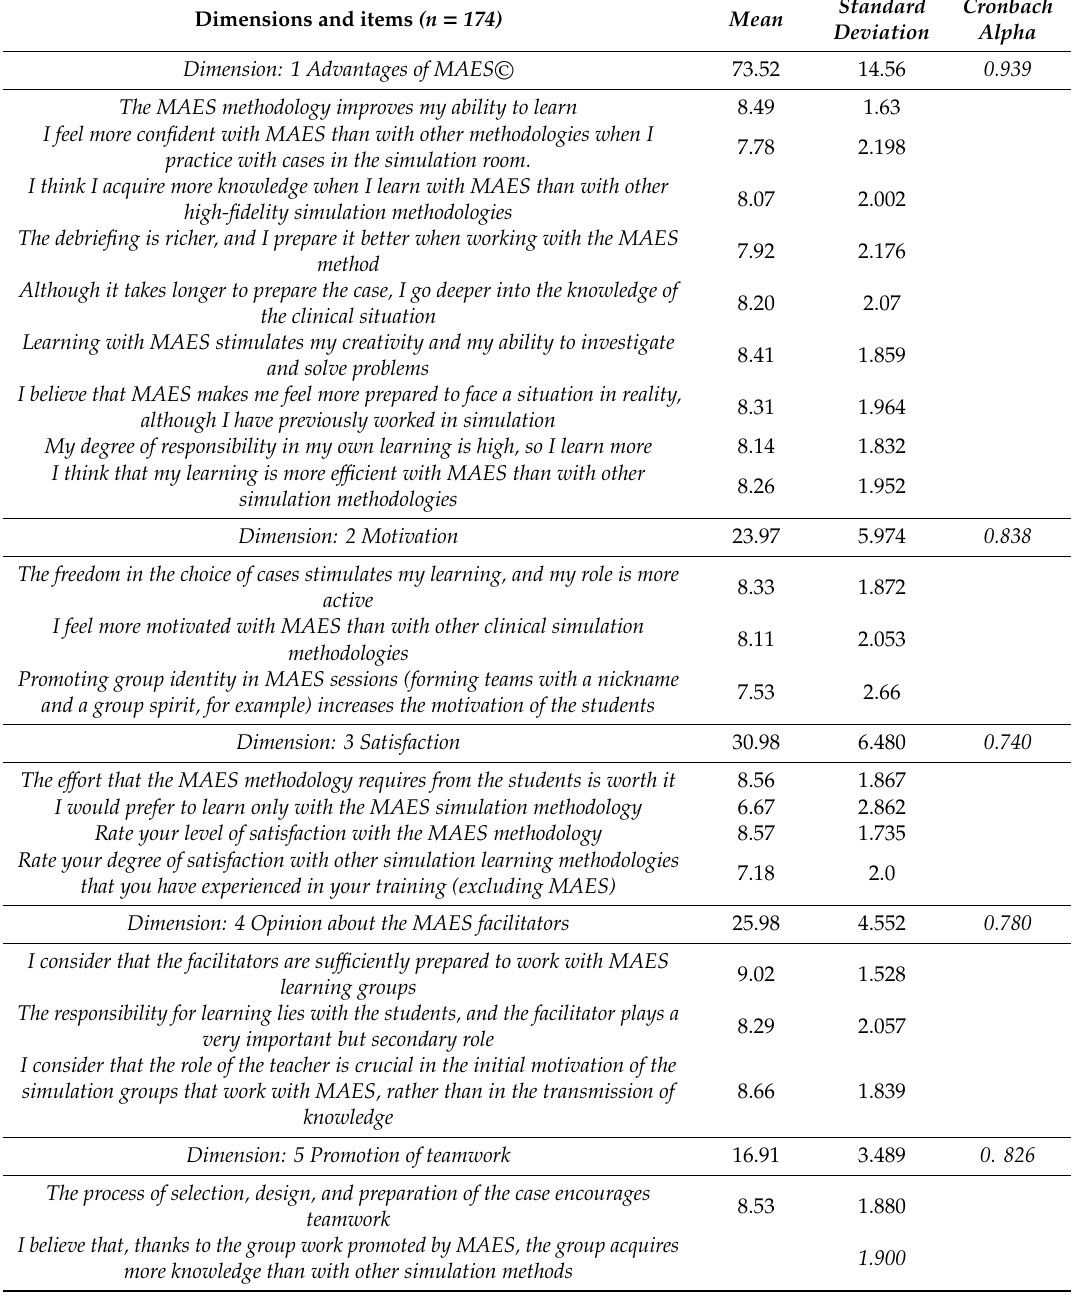
Table 1. Statistical description of the dimensions and items of the questionnaire, as well as Cronbach alpha of the dimensions. Self-Learning Methodology in Simulated Environments (MAES © ) Dimensions and items (n =